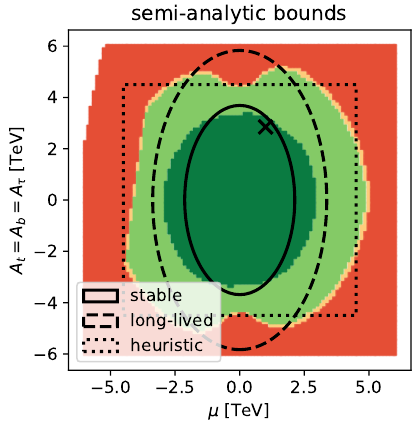
Figure 5 . Constraints from vacuum stability in the plane of (cid:22) and A containing the selected point (black (cid:2) ) from the M 125 benchmark scenario. The results from (cid:12)gure 4 are shown with h superimposed contours indicating the approximate absolute and metastability bounds of eq. (4.3) and the heuristic bound of eq.